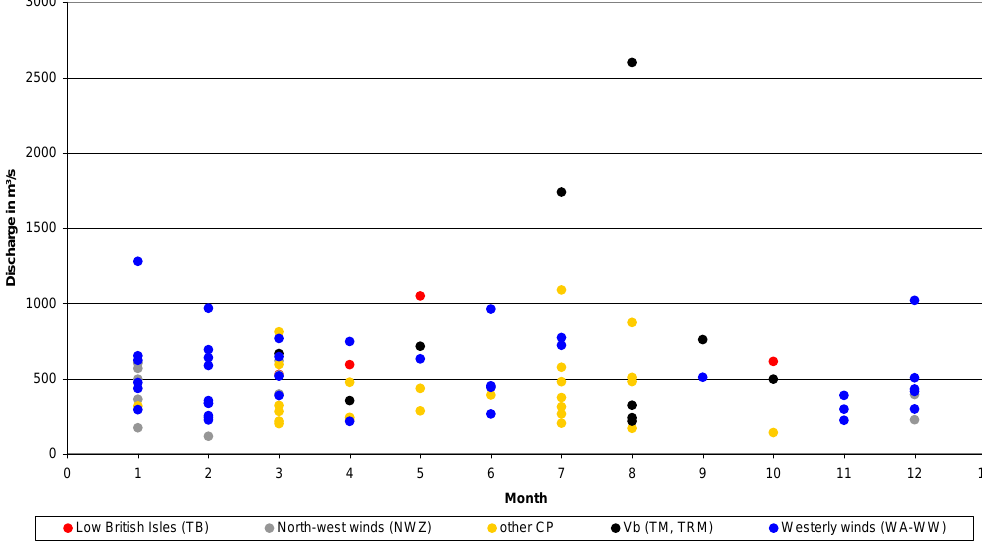
Fig. 7. Skewness (A) and coefficient of variation (B) of the discharge AMS for the 15 gauges. Figure 7: Skewness (A) and coefficient of variation (B) of the discharge AMS for the 15 Figure 7: Skewness (A) and coefficient of variation (B) of the discharge AMS for the 15 Monthly distribution of AMS discharges at Golzern and the assigned circulation pattern gauges gauges